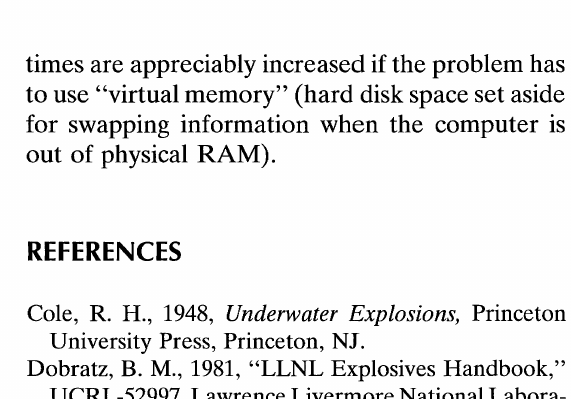
Table 1. Execution Sunnnary